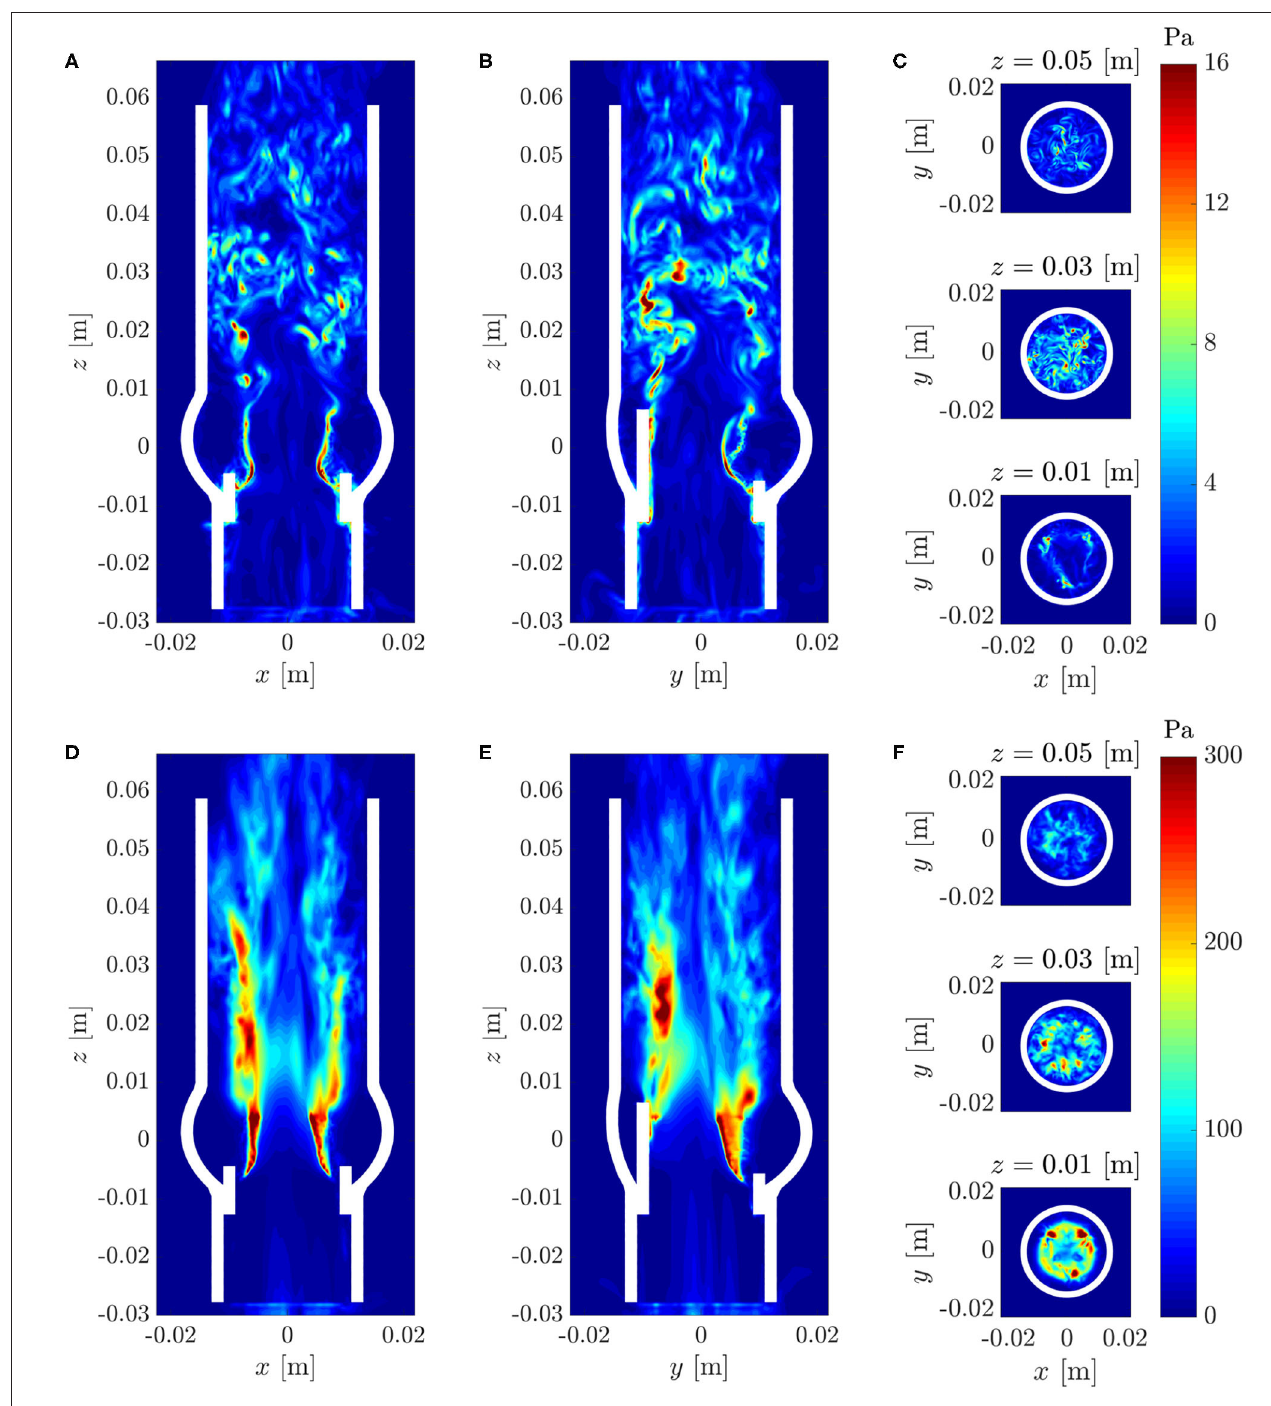
FIGURE 10 | (A–C) Instantaneous maximum viscous shear stress τ max at t = 0.3s; (D–F) Maximum Reynolds shear stress RSS max (same cross-sections as in Figure 7 ).